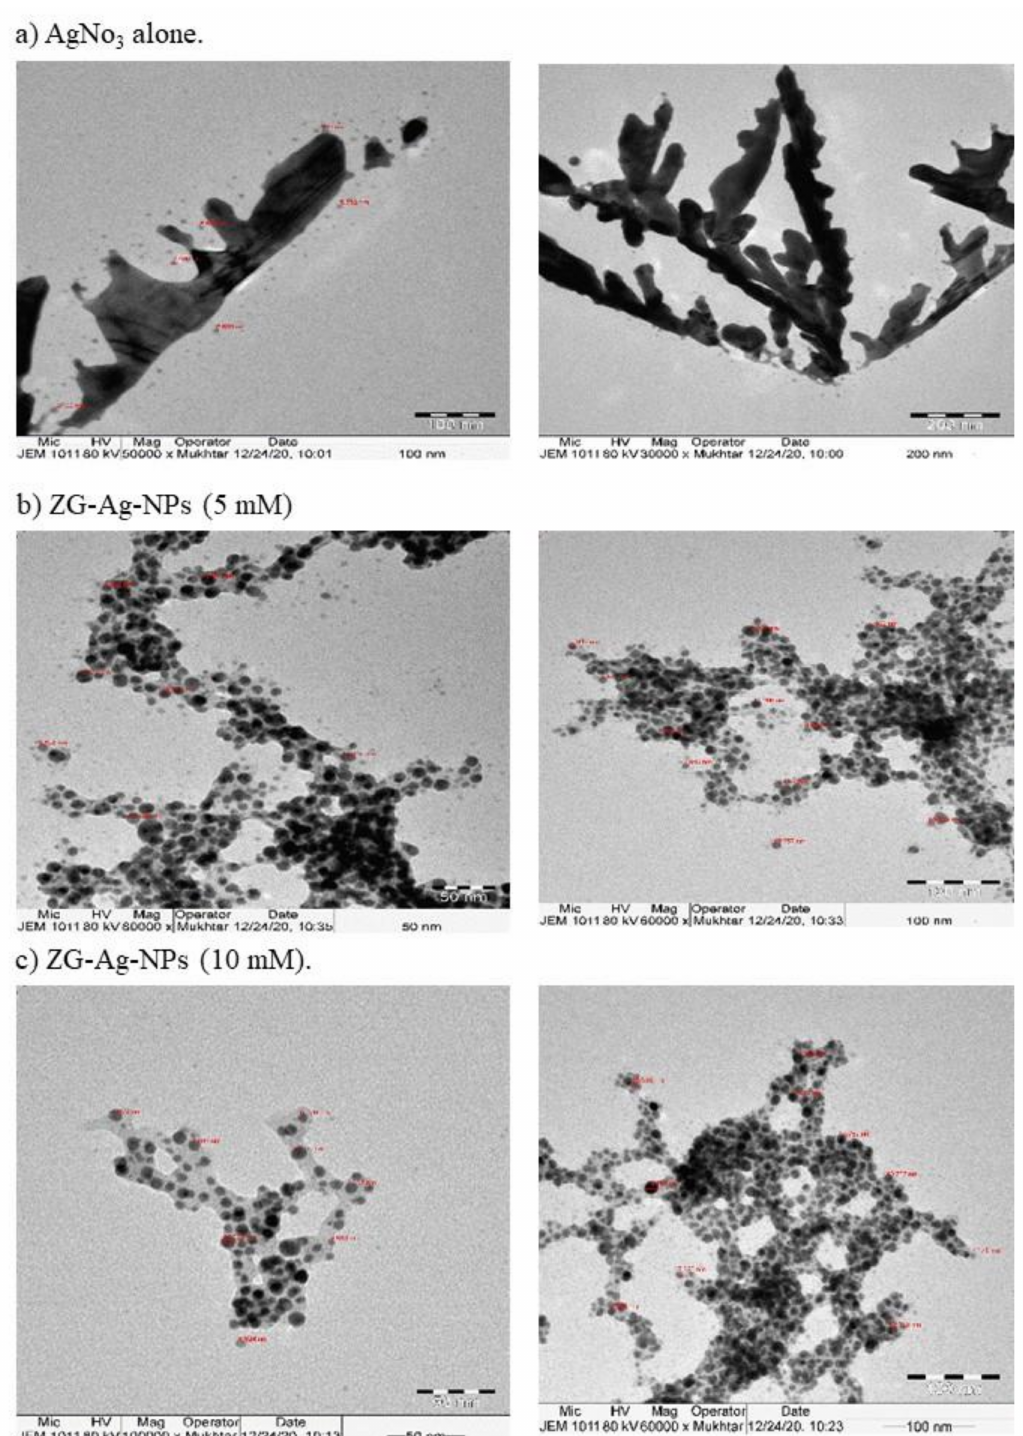
Figure 1. TEM images of AgNO 3 ( a ), 5 mM ZS-Ag-NPs ( b ), and 10 mM ZS-Ag-NPs ( c